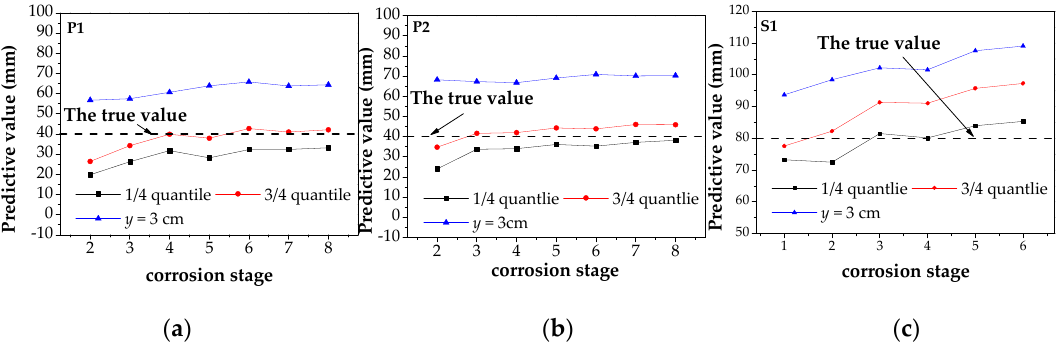
Figure 20. The predicted results of corrosion width of three specimens under different corrosion stages: ( a ) The predicted results of P1; ( b ) the predicted results of P2; ( c ) the predicted results of S1. P1: the parallel wire strand made of seven steel wires; P2: the parallel wire strand made of 19 steel wires; S1: the steel strand.